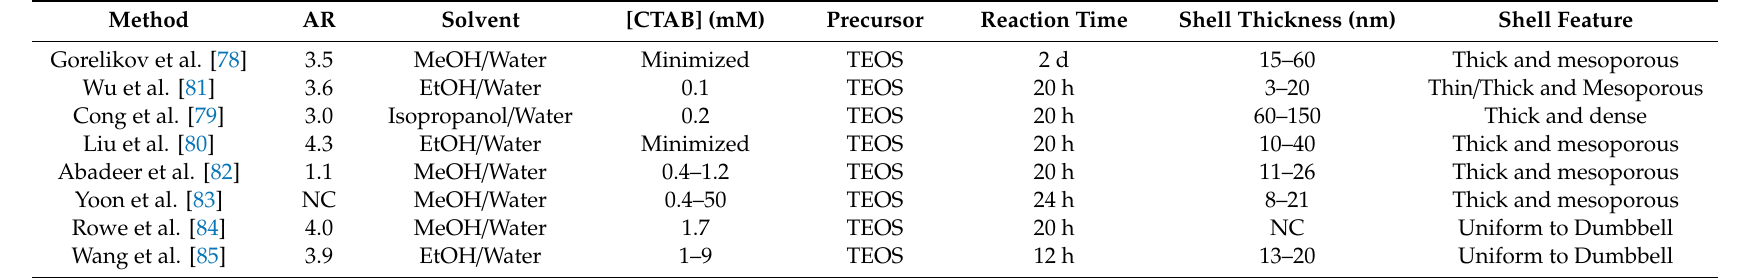
Table 3. Summary of the reaction conditions for direct silica coating on AuNRs with respective silica shell size and